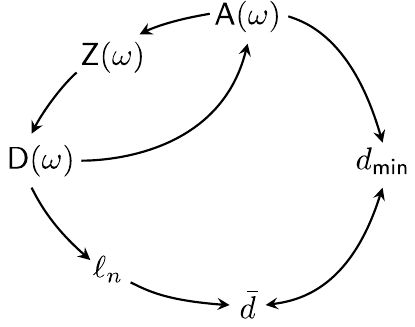
Figure 2. The integration scheme can be schematically represented by the “circle of consistency”.